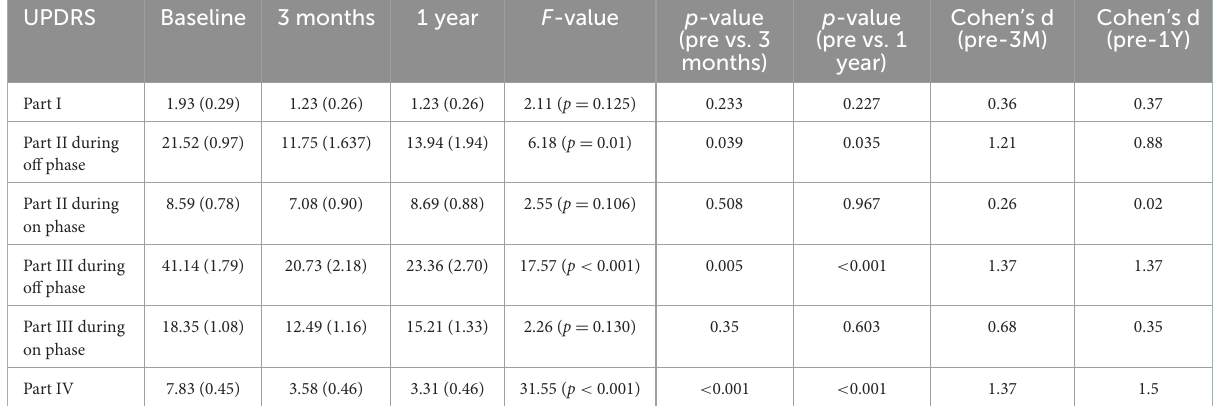
TABLE 1 Scores for UPDRS at baseline and follow-up points after surgery (3 months and 1 year after surgery).